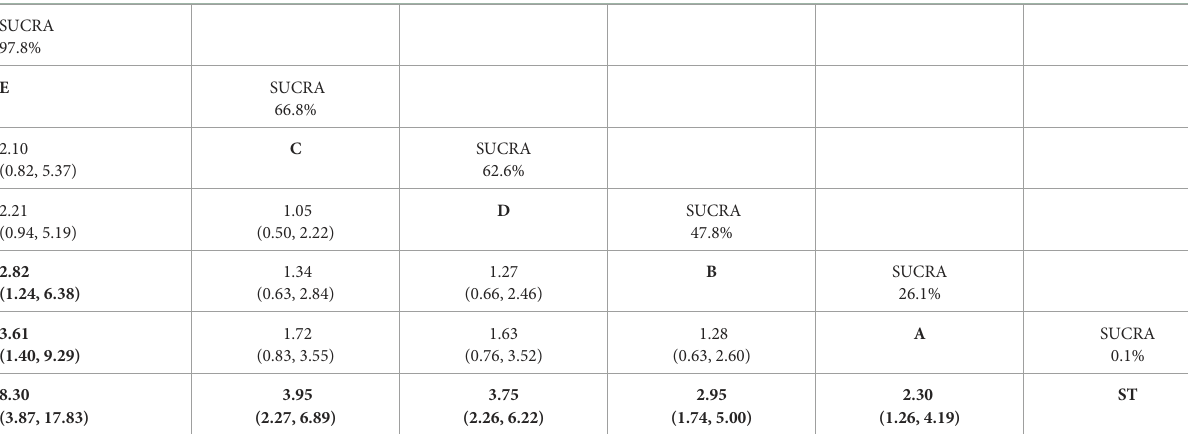
FIGURE3 Comparison-adjusted funnel plots for the CER network. ST, Speech training; BA, body acupuncture; SA, scalp acupuncture; TA, tongue acupuncture; SBA, scalp-body acupuncture; STA, scalp-tongue acupuncture.